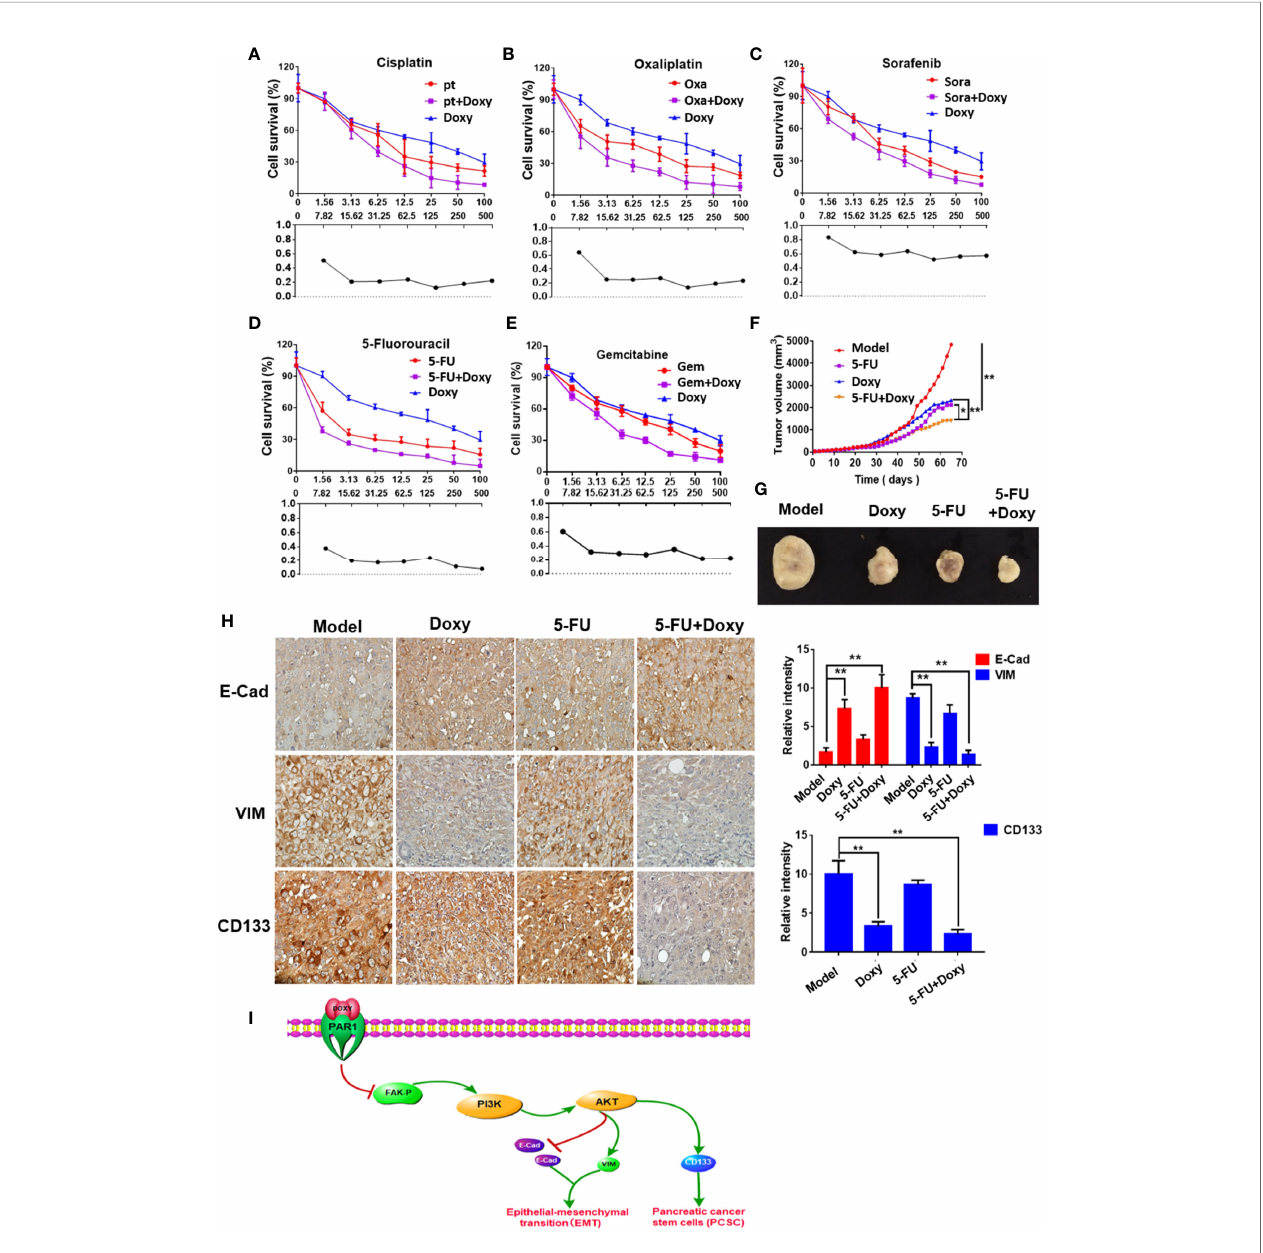
FIGURE 7 | Doxycycline inhibits pancreatic cancer growth and enhances the therapeutic effect of 5-FU. (A – E) The sensitization effect of doxycycline for chemotherapeutic drugs in Panc-1 cells after 72 h treatment. (F, G) The tumor volume change of Panc-1 subcutaneous xenografts in doxycycline, 5-FU, and the combination treatment group. (H) Immunohistochemical staining for E-cad, VIM, and CD133 in tumor tissues. Data are shown as the mean ± SD (* P < 0.05, ** P < 0.01). (I) Molecular mechanism of doxycycline inhibits cancer stem cell-like properties of pancreatic cancer.